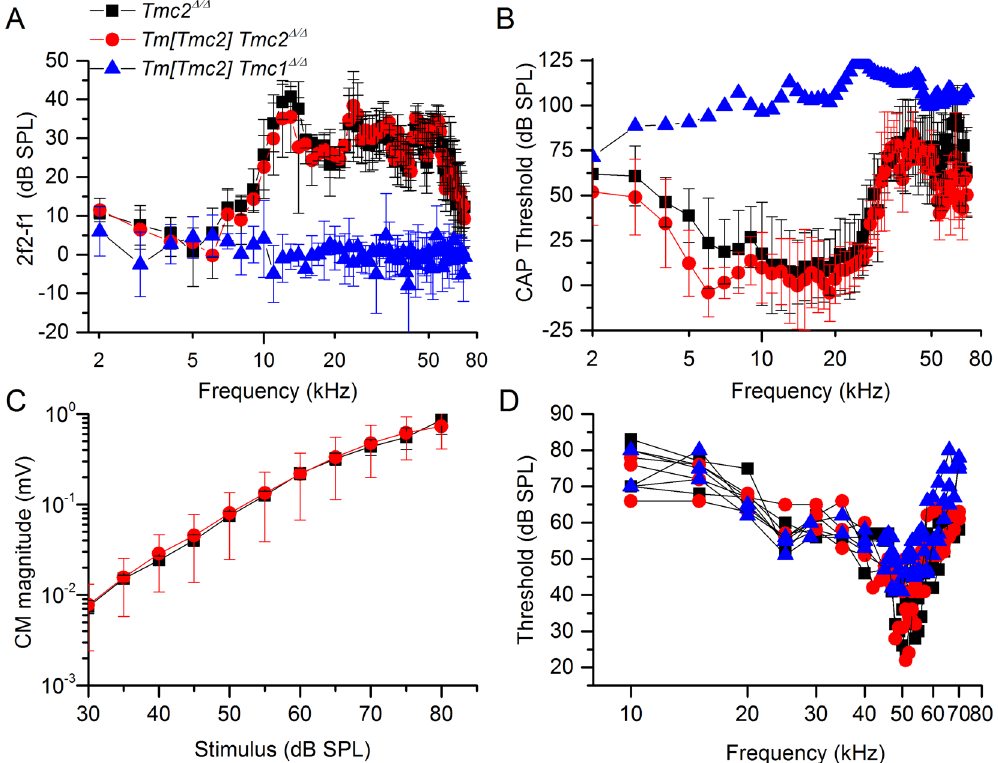
Figure 7. Tm [ Tmc2 ] expression does not disrupt auditory function in Tmc2 Δ / Δ mice but fails to rescue auditory function in Tmc1 Δ / Δ mice. Recordings were performed from 8 Tm [ Tmc2 ] ;Tmc2 Δ / Δ (red), 7 Tmc2 Δ / Δ (without Tm [ Tmc2 ], black) littermates, and 8 Tm [ Tmc2 ] ;Tmc1 Δ / Δ mice (blue). ( A ) Similar, sensitive, distortion product otoacoustic emission (DPOAE) audiograms (2f1-f2 DPOAE magnitude as function of f2 frequency, mean ± S.D.) recorded from Tm [ Tmc2 ] ;Tmc2 Δ / Δ and Tmc2 Δ / Δ mice. No DPOAEs were recorded above the noise floor (0 dB SPL) from Tm [ Tmc2 ] ;Tmc1 Δ / Δ mice. DPOAEs were recorded from the auditory meatus. F1 was set at 70 dB SPL and f2 was set at 60 dB SPL. ( B ) Similar, sensitive, compound action potential (CAP recorded from the round window) audiograms (CAP threshold as a function of stimulus frequency, mean ± S.D.) were recorded from Tm [ Tmc2 ] ;Tmc2 Δ / Δ and Tmc2 Δ / Δ , but not from Tm [ Tmc2 ] ;Tmc1 Δ / Δ mice as indicated by the blue line (upper SPL of sound system). ( C ) Cochlear microphonic potential (CM) as a function of the level of the 5 kHz stimulus tone (mean ± S.D.) recorded from the round window are almost identical in Tm [ Tmc2 ] ;Tmc2 Δ / Δ and Tmc2 Δ / Δ mice. CM was not elicited from Tm [ Tmc2 ] ;Tmc1 Δ / Δ mice for any level of the 5 kHz tones. ( D ) measured from Tm [ Tmc2 ] ;Tmc1 Δ / Δ mice resemble post-mortem responses from Tm [ Tmc2 ] ;Tmc2 Δ / Δ and Tmc2 Δ / Δ , mice. Measurements were confined to mice aged